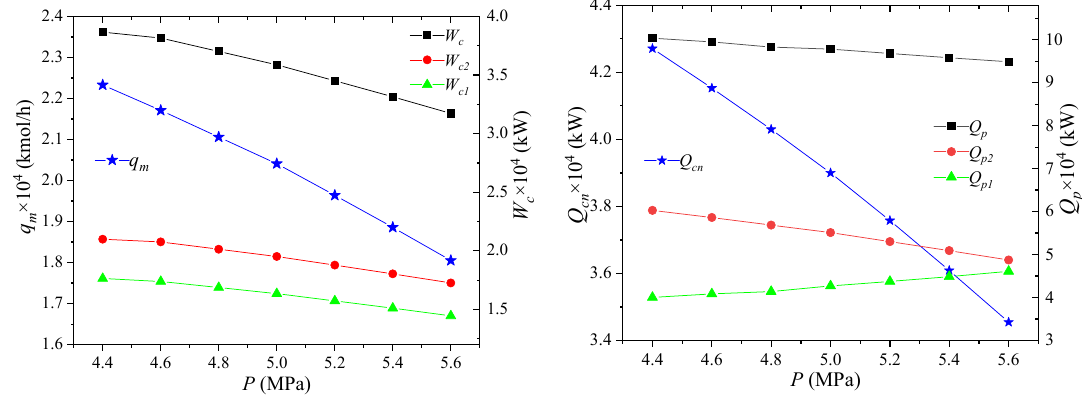
Figure 4. E ff ects of NG pressure on process